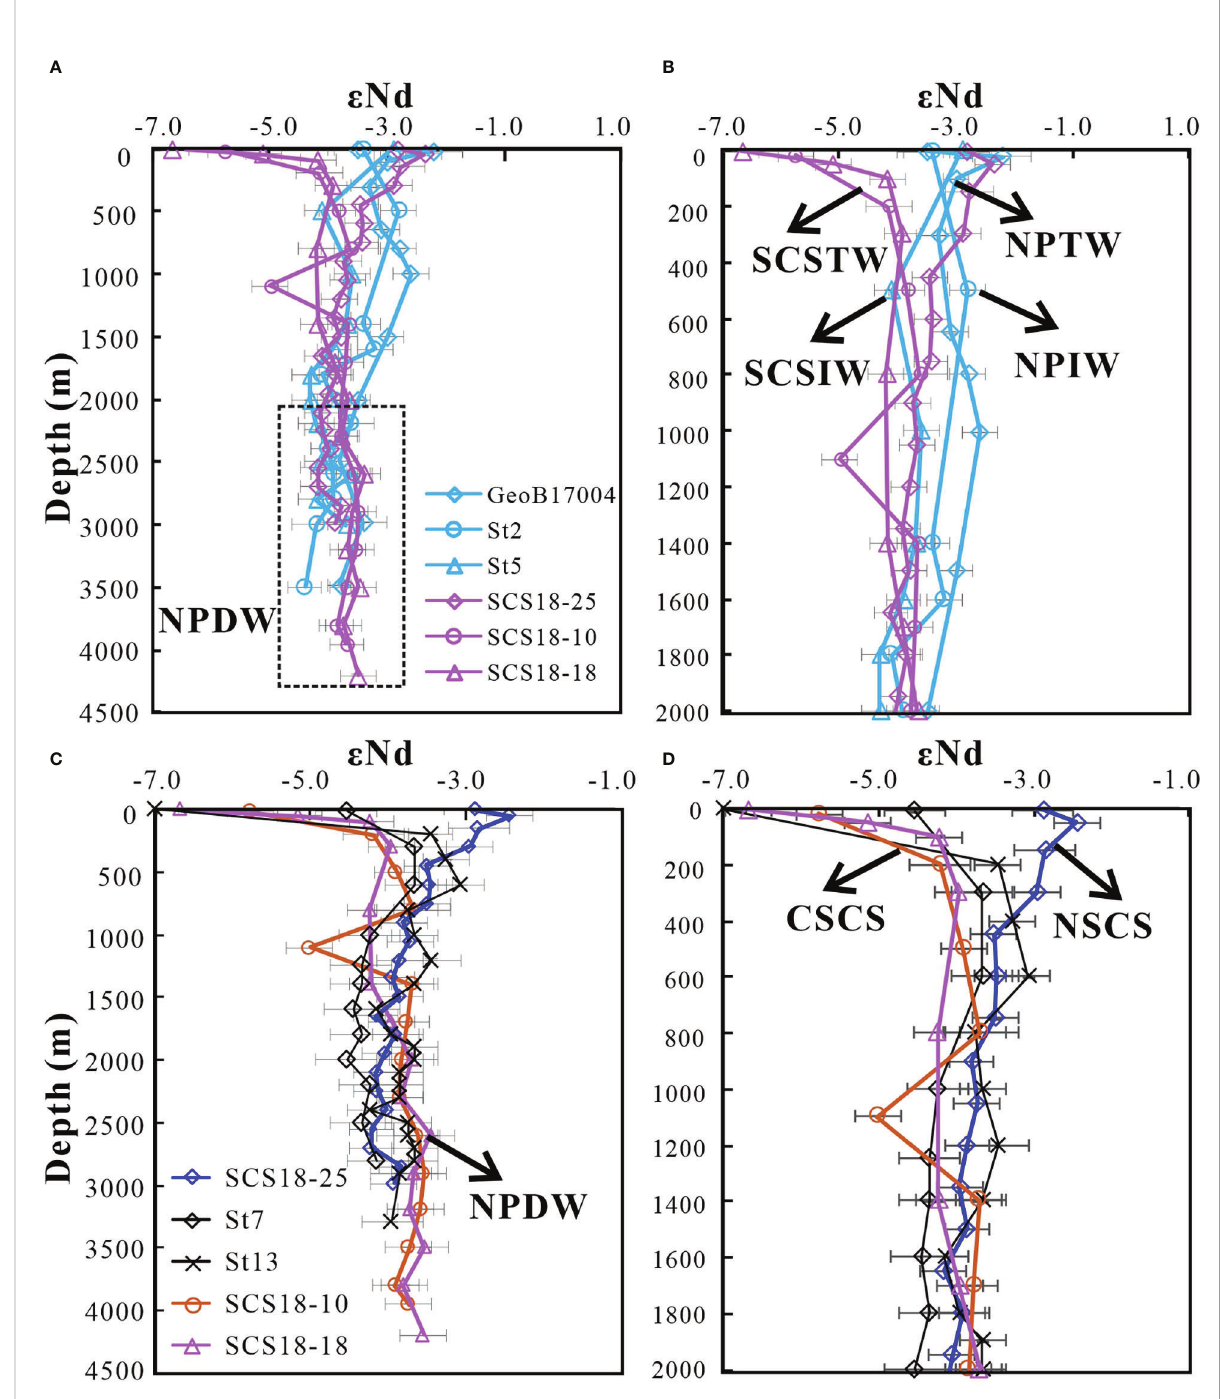
FIGURE 9 Comparisons of ϵ Nd vertical pro fi les between the SCS and the North Paci fi c (A, B) , and within the SCS (C, D) . ϵ Nd values of the North Paci fi c are from Wu et al. (2015); Behrens et al.